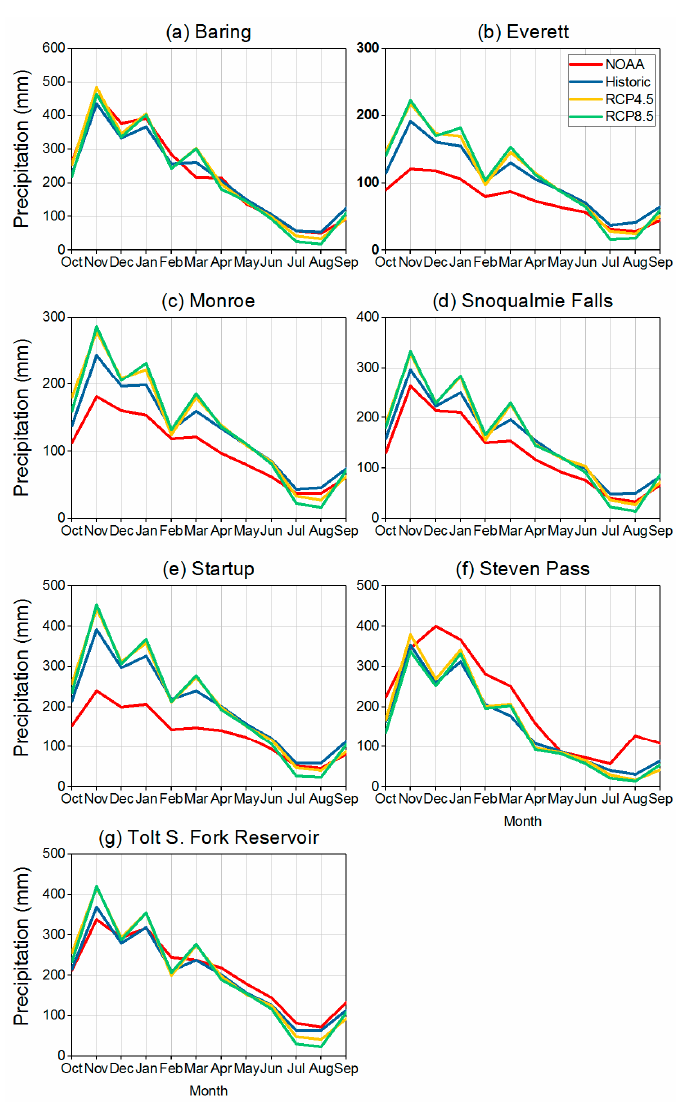
Figure 4. The mean monthly precipitation from seven climate data sets at seven Snohomish watershed locations.